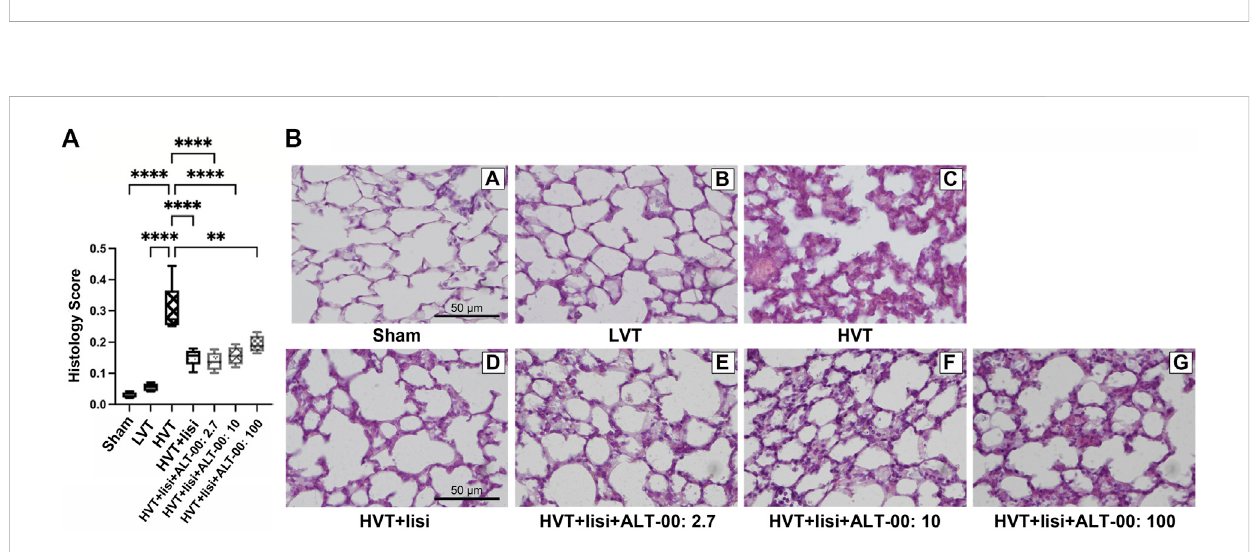
FIGURE 8 Histological lung injury score and representative histological images. (A) The lung histology scores for acute lung injury were upregulated after high tidal volume (HVT) ventilation. The histology score of the HVT group was increased versus the sham and low tidal volume (LVT) groups (**** p < 0.0001), and was improved by lisinopril (lisi) ± ALT-00 (**** p < 0.0001, ** p = 0.002). n = 7/group, compared by analysis of variance with Tukey posttest. (B) Representative hematoxylin-eosin-stained histologicalimagesof eachgroup, magni fi cation ×40: Thesham group(B/A)showed normal lung tissue structures and morphology. In the LVT group (B/B) the lung tissue sections showed a few hyaline membranes and neutrophils. The HVT group (B/C) showed neutrophil in fi ltration in the alveolar and interstitial space, extensive diffuse congestion with proteinaceous debris in the airspaces and